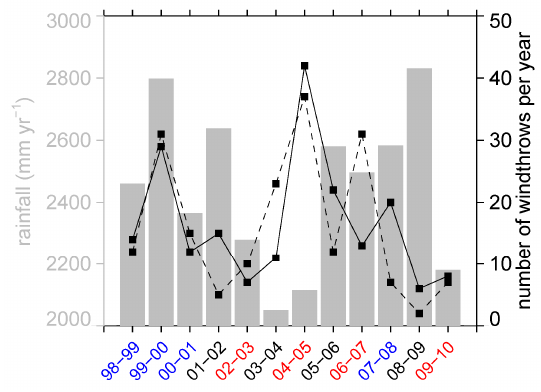
Figure 5. Annual occurrence of windthrow events (solid and dashed lines) over hydrological years 1998–1999 to 2009–2010 plotted against annual rainfall (gray bars). Rainfall data taken from Tropical Rainfall Measuring Mission 3B43 (TRMMmo) as described in Section 2.2. Rainfall data and windthrows correspond to the area covered by the Landsat tile P231/R062 as described in Section 2.1. HY (Hydrological year) case plotted in the solid line and HYb plotted in the dashed line. La Niña years highlighted in blue, El Niño years highlighted in red.